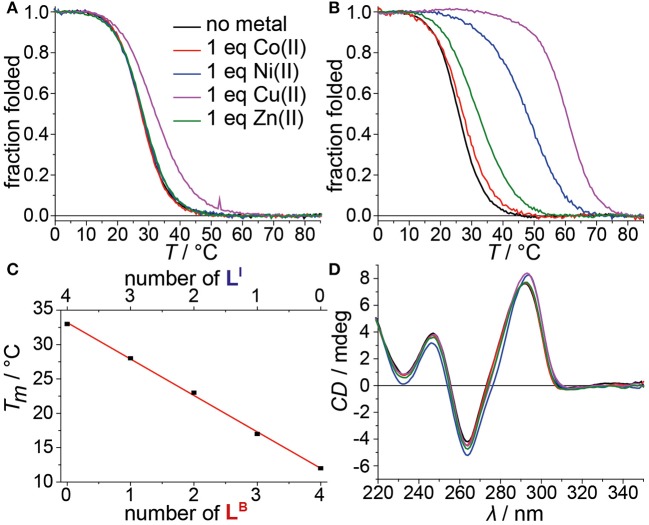
Melting curves of (A) htelLBLI
3 and (B) htelLB
2LI
4 in absence or presence of different transition metal cations. (C) Linear dependence of thermal stabilities of htelLI
4, htelLBLI
3, htelLB
2LI
2, htelLB
3LI, and htelLB
4 depending on the number of incorporated LB. (D) CD spectra of htelLB
2LI
4 in absence or presence of different transition metal cations.